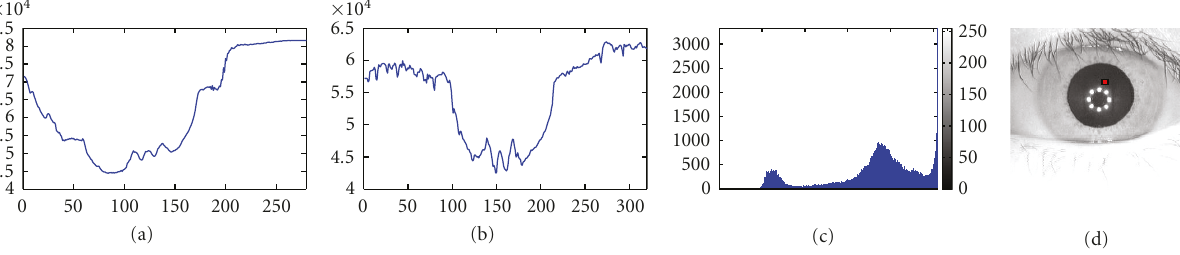
Figure 8: (a) Horizontal histogram, (b) Vertical Histogram, (c) Overall Histogram of the image, and (d) Estimated center.